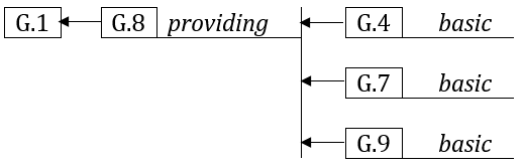
Figure 1: The scheme of sequence of ensuring the realization of the goal 1 of sustainable development